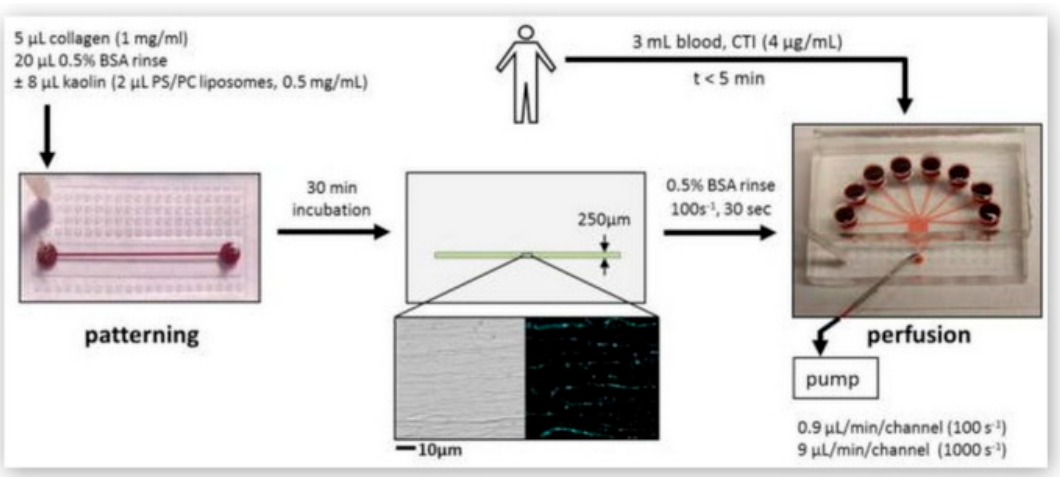
Figure 16. Experimental set-up: Collagen / kaolin patterned to a glass slide with a thickness of 250 µm. The microfluidic device with 8 inlets was then bonded to the glass slide. Taken with permission from [135].